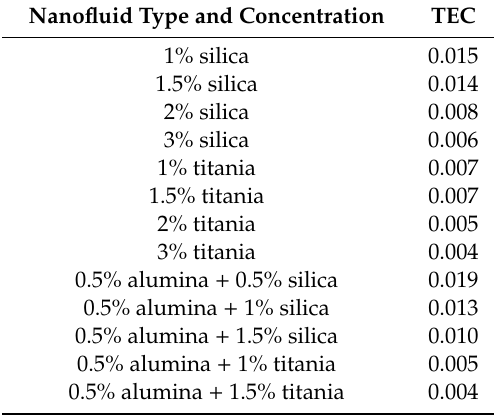
Table 4. Thermo-electrical conductivity ratio (TEC) values for studied simple and hybrid